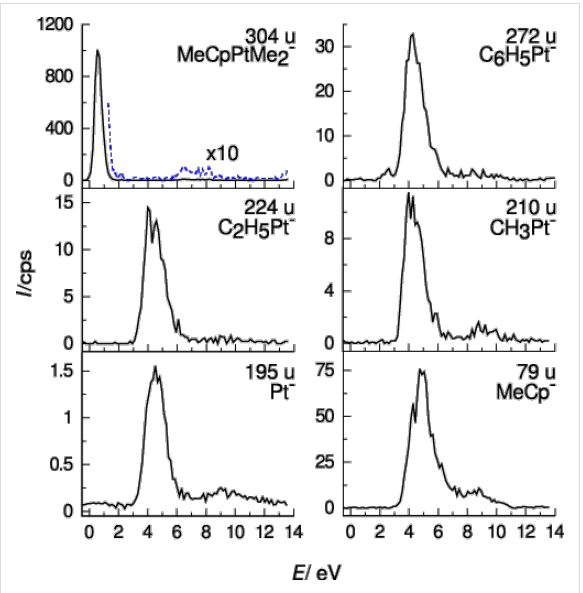
Figure 7: Energy-dependent relative cross sections (ion yields) of negative ion fragments produced by DEA to MeCpPtMe 3 . Reproduced with permission from [15], Copyright (2012) Royal Society of Chem-